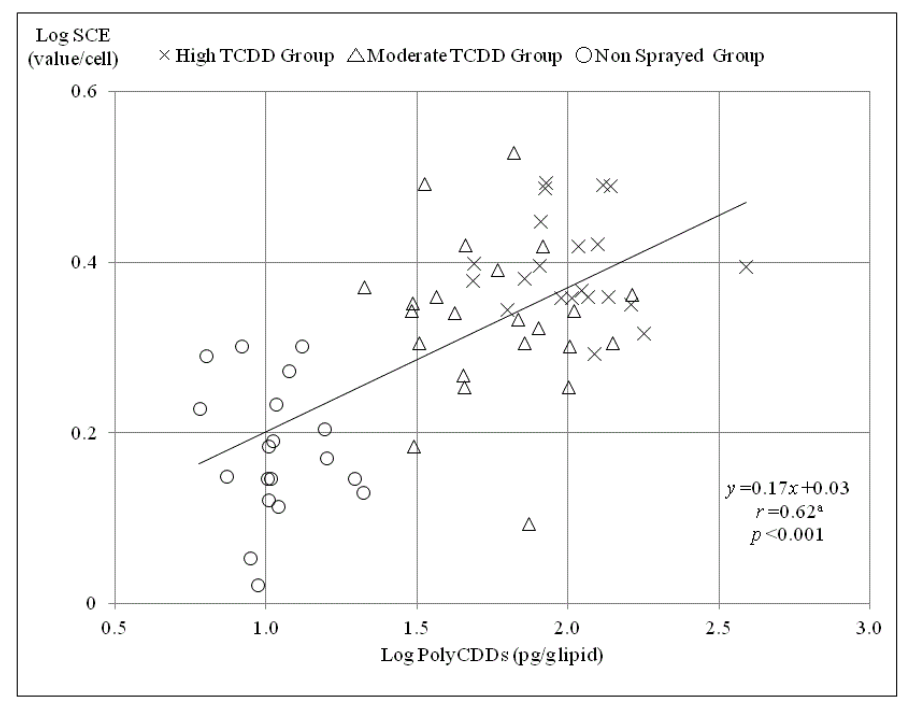
Figure 1. Comparison with the correlation between SCE and total